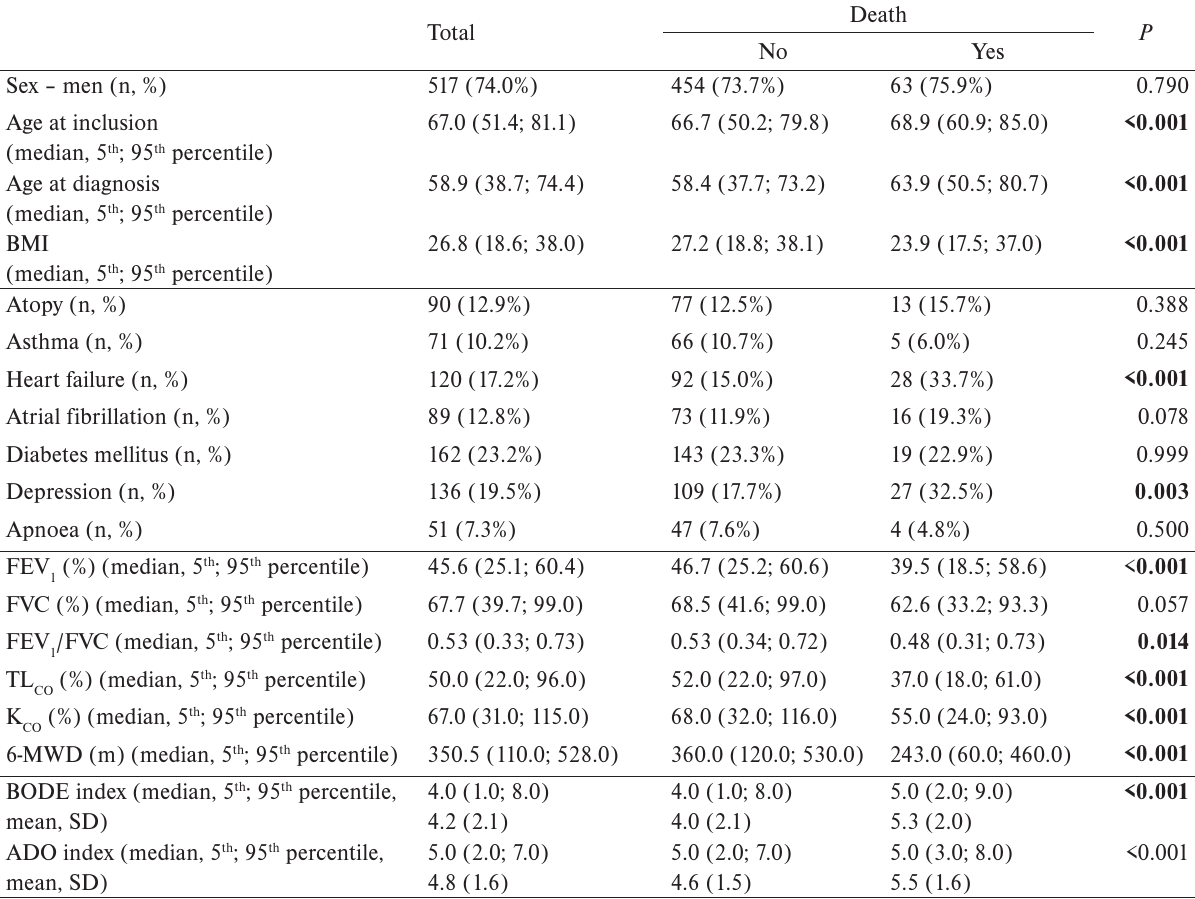
Table 1. Descriptive statistics of the derivation (CZ) cohort (n=699).